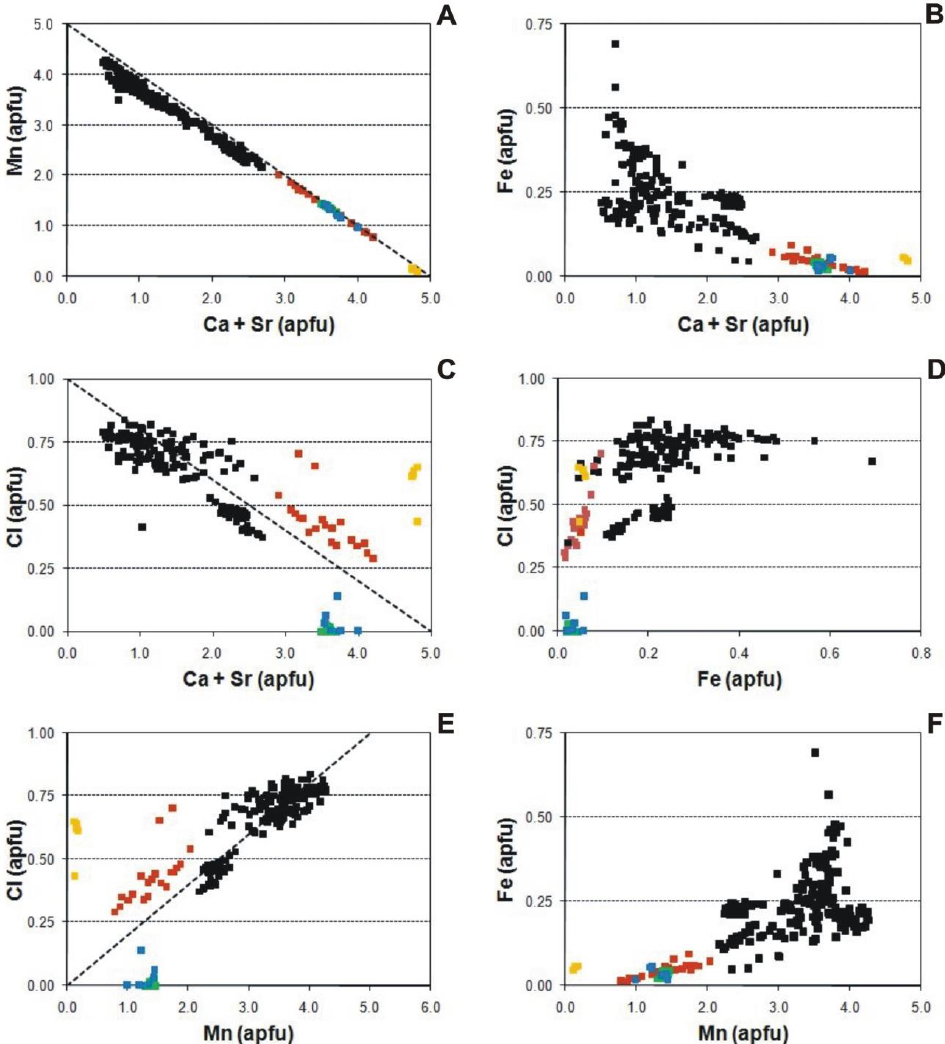
Figure 4. Correlations Ca + Sr vs. Mn ( A ), Ca+Sr vs. Fe ( B ), Ca+Sr vs. Cl ( C ), Fe vs. Cl ( D ), Mn vs. Cl ( E ), and Mn vs. Fe ( F ) in the structure of apatites from the Szklary pegmatite. Colours as in Figure 3, dashed line: ideal trend in the pieczkaite–hydroxylapatite solid solution, Mn 5 (PO 4 ) 3 Cl–Ca 5 (PO 4 ) 3 OH.